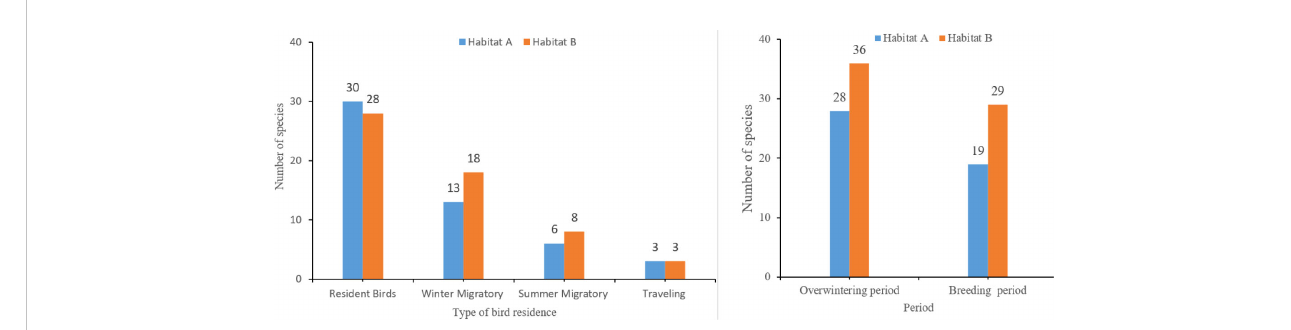
FIGURE 5 Changes in bird residential types and bird species during the migration season in different habitats.